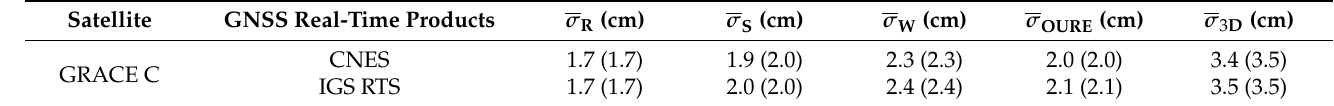
Table 5. Averaged RMS of the orbital errors and the OUREs for GRACE C in 6–12 August 2022 with less healthy data status. The results without outlier exclusions are given in parentheses.